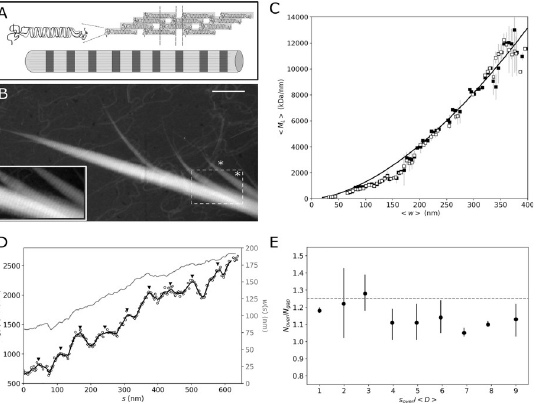
Fig 5. Mapping axial order in a telocollagen fibril. (A) Scheme of the quarter-staggered lateral assembly of collagen, resulting in a periodic pattern of overlap and gap regions. (B) STEM image of a single fibril from a telocollagen network. The inset is a magnification of the area in the white dashed square, where the contrast has been optimized to show the D-spacing pattern. Scale bar 1 μ m. (C) Average M L values as a function of w for the overlap (black squares) and gap (white squares) regions in the image shown in (B). The solid black line shows the fit to Eq. (1) with α = 1.67. (D) Axial mass profile for the fibril indicated with an asterisk in (B). The white circles show the raw M L data, and the black line the smoothed data. The corresponding width profile is shown in gray. The black upside triangles indicate the positions of the overlap regions s over (E) Ratio between the number of tropocollagen molecules per cross section in the overlap ( N over ) and gap ( N gap ) regions of the profile shown in (D). The x-axis shows the axial position of the overlap ), normalized by the mean D-spacing of the fibril, < D > = 66.7 ± 5.4 nm. region ( s over